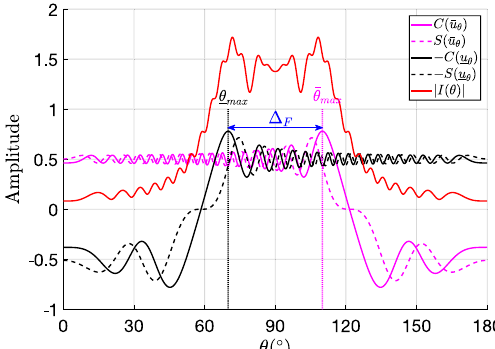
Fig. 3 Highlight of the match between the Fresnel angular distance and the beam